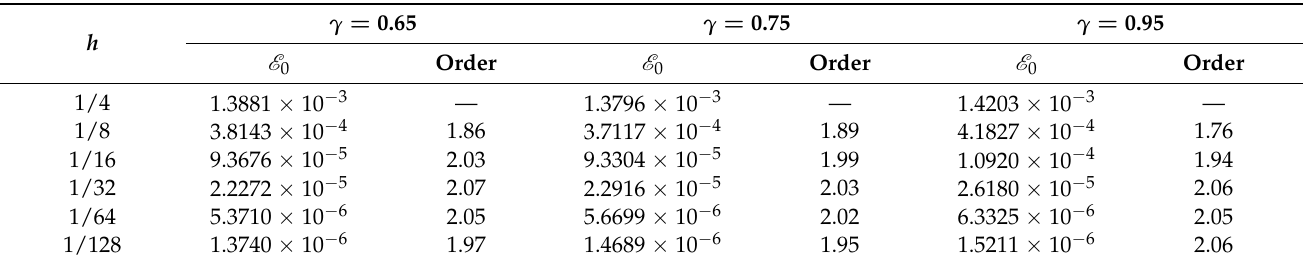
Table 1. E 0 and numerical convergence order in the spatial direction ( k = 1.25 × 10 − 6 ).